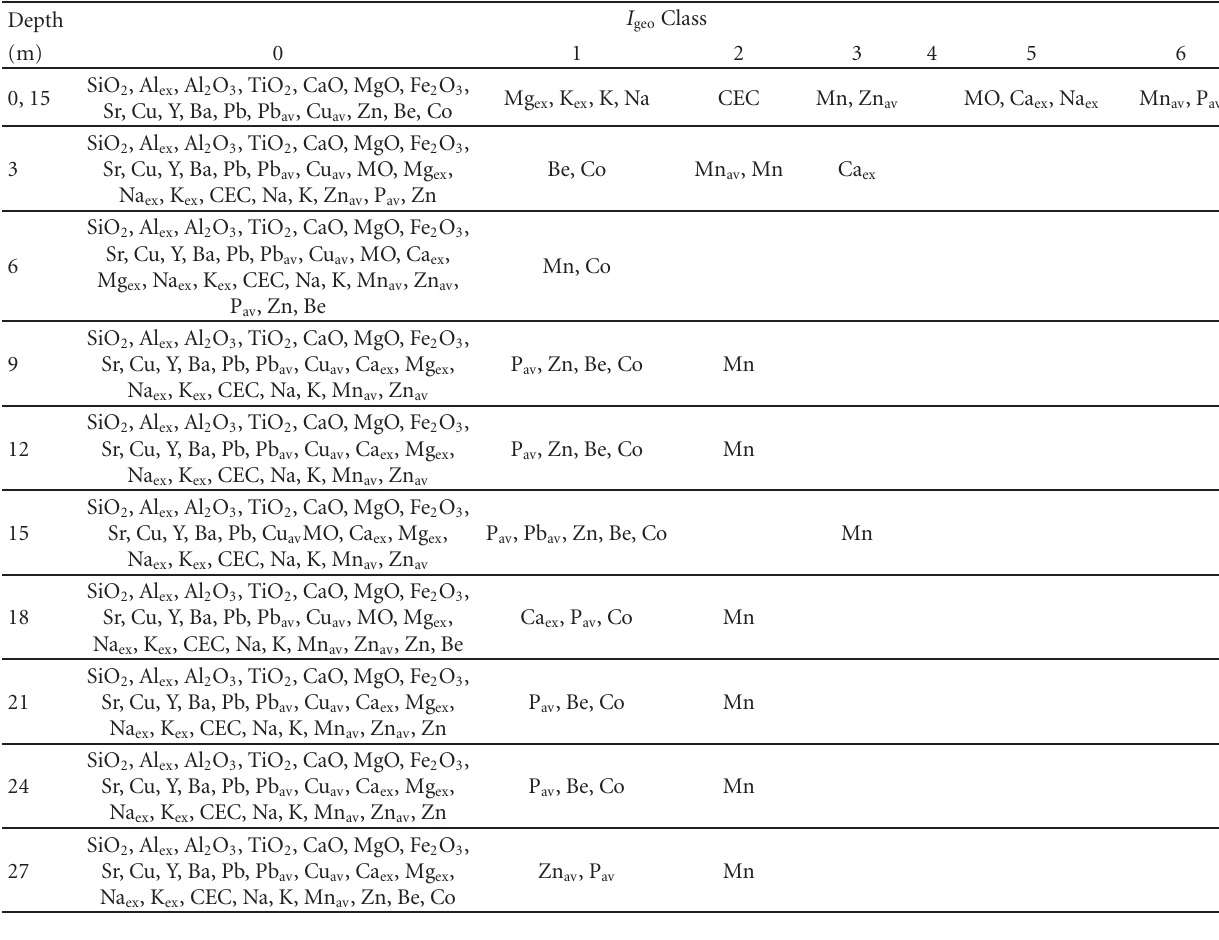
Table 4: Geoaccumulation indexes obtained in soil samples from the WTS monitoring well.